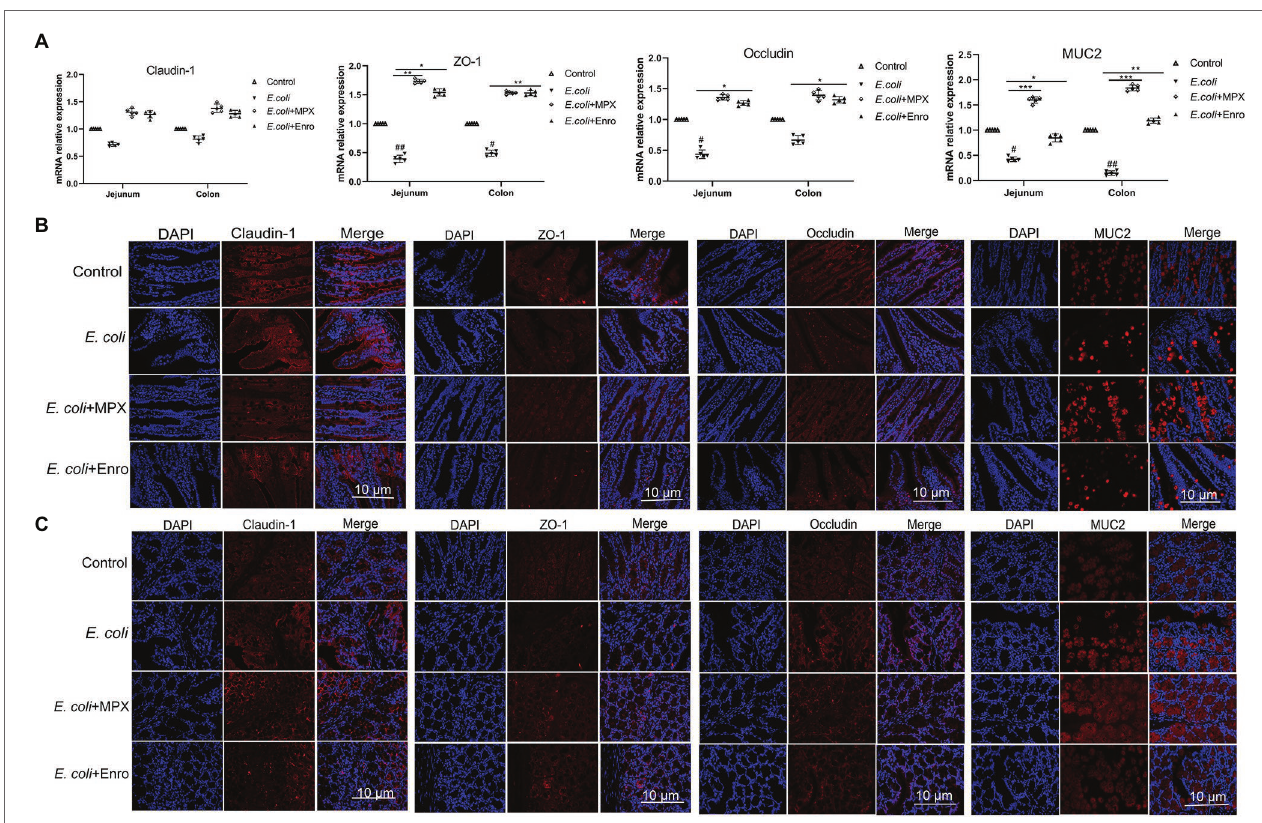
FIGURE 7 | MPX improves the expression of tight junction proteins and mucin in the jejunum and colon. (A) The mRNA expression of claudin-1, ZO-1, occludin and MUC2 in the jejunum and colon. (B) The protein expression of claudin-1, occludin, ZO-1 and MUC2 (red) and DAPI (blue) in the jejunum. (C) The protein expression of claudin-1, occludin, ZO-1 and MUC2 (red) and DAPI (blue). Scale bar = 10